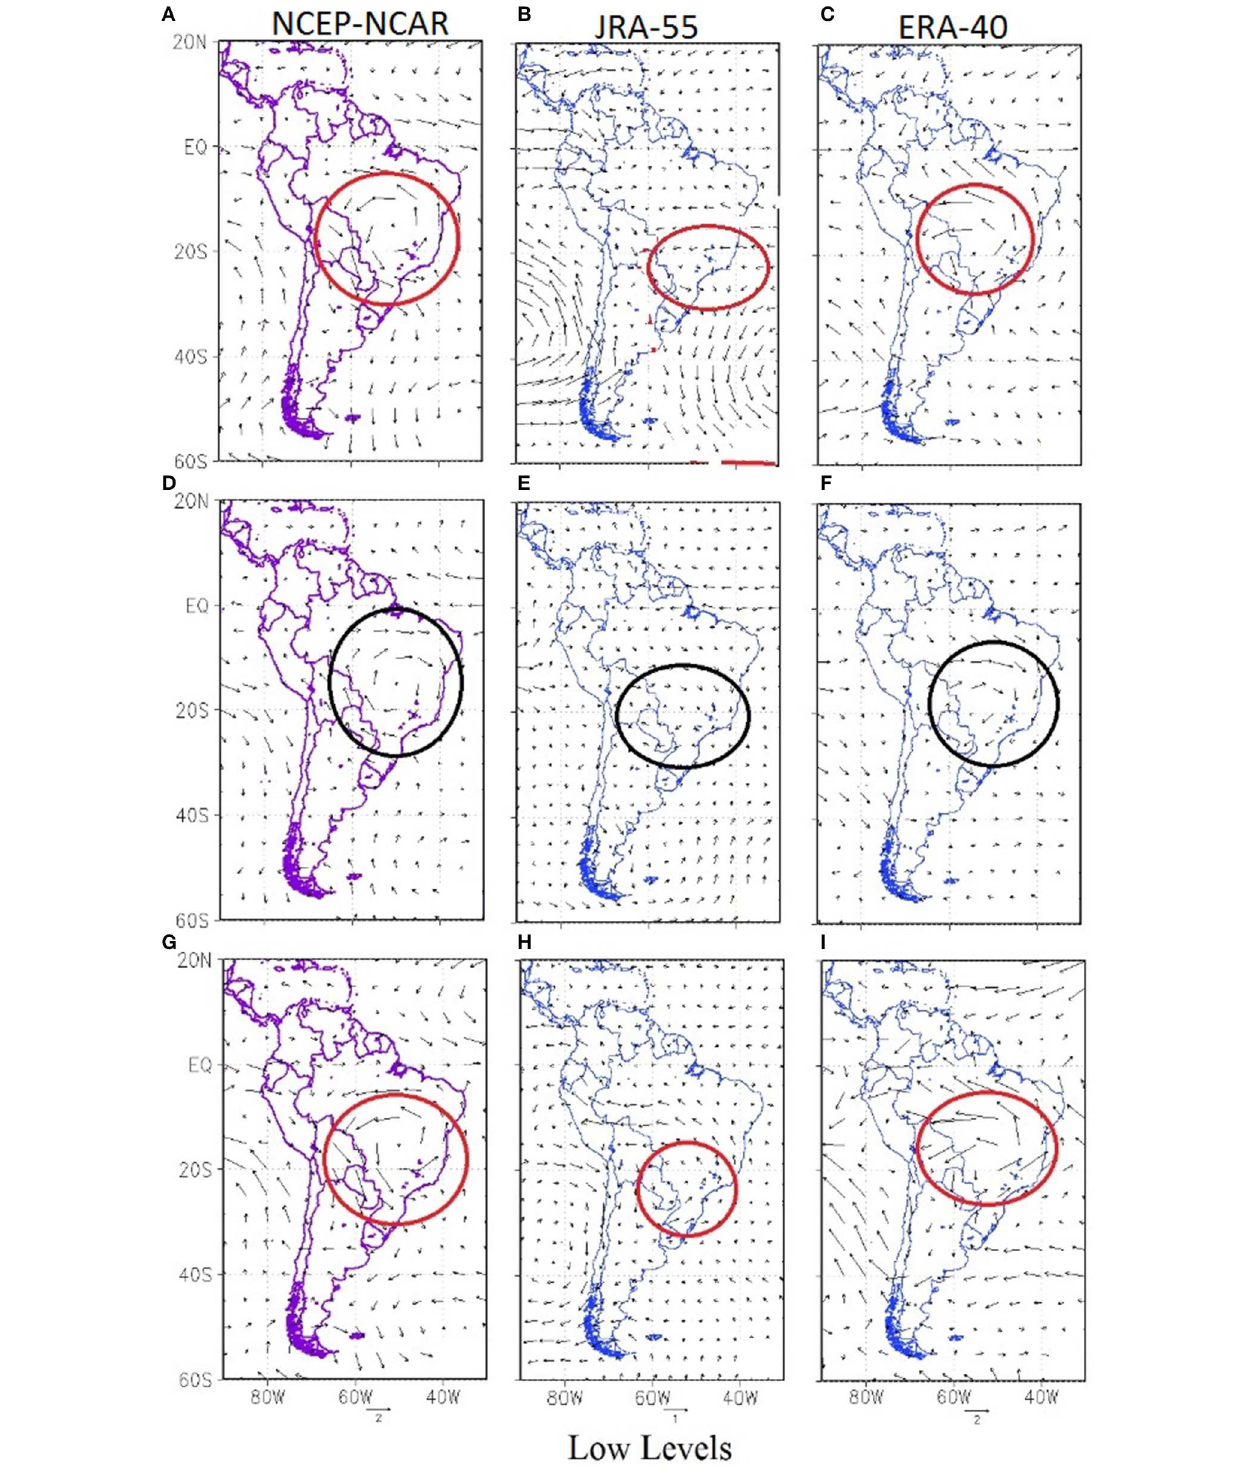
FIGURE 4 | Same as Figure 3 but for low levels (850–600 hPa). Black (red) circles represent regions with a predominance of cyclonic (anticyclonic) wind movements.